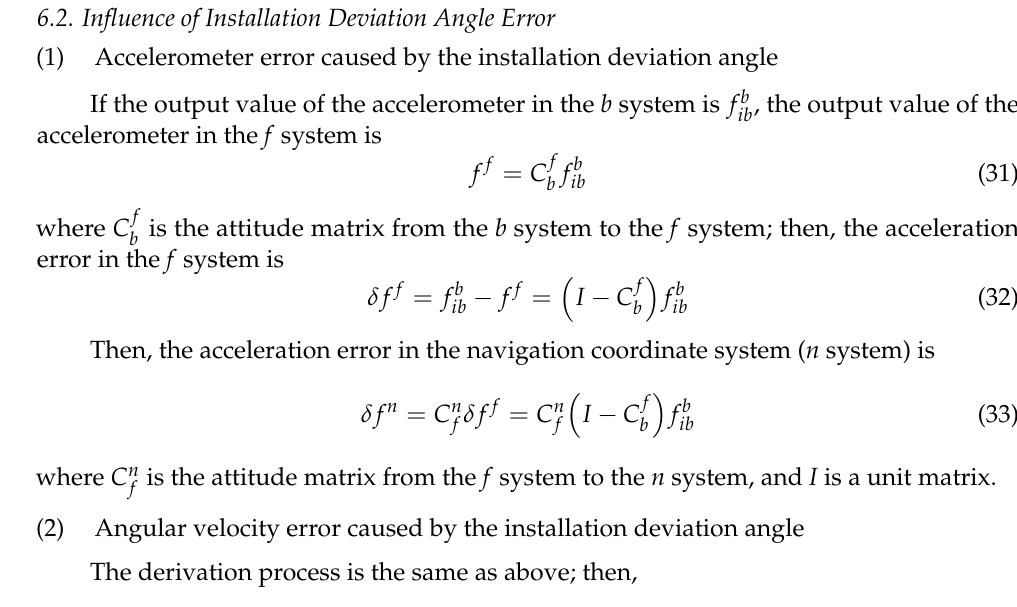
Figure 10. Pitch deviation angle of SINS.